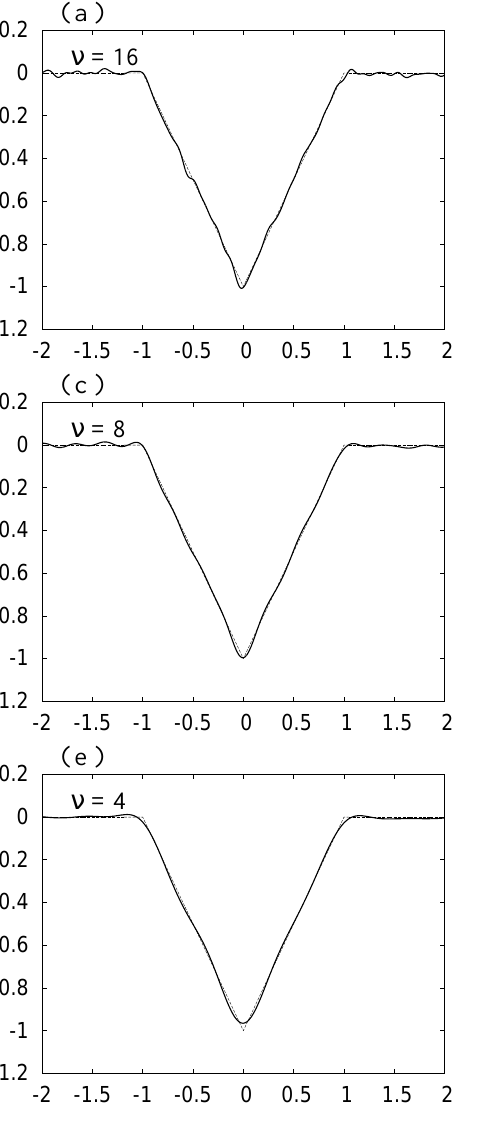
( x ) based on the rdH-wavelet using l = 1 ν f ( x ) and ( M ν 1